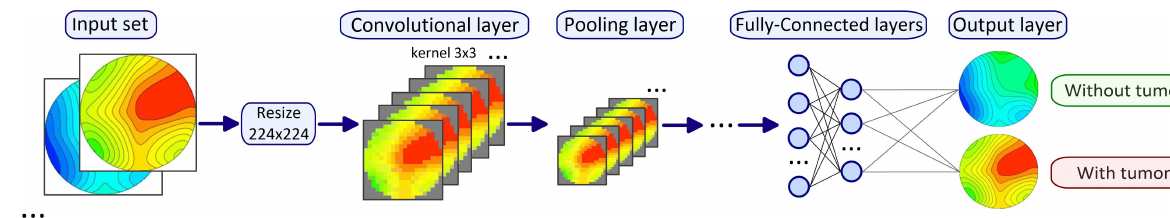
Figure 15. Used CNN scheme for binary classification of thermometric